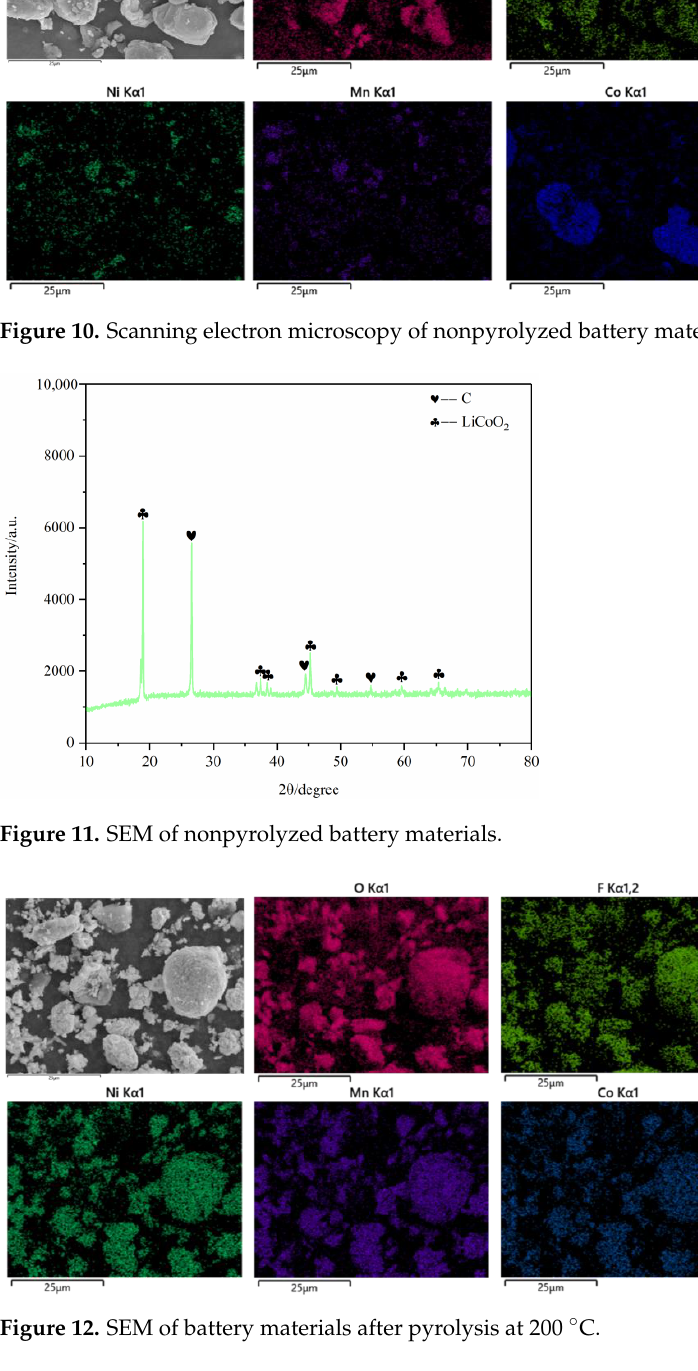
Figure 13. XRD of battery materials after pyrolysis at 200 °C. As shown in Figure 14, the battery materials were pyrolyzed at 400 °C in an N2 at- mosphere. After pyrolysis, the battery materials were broken and analyzed by scanning electron microscopy. At the same time, an XRD test was carried out on the battery material, and the results showed that the main phase in the battery material did not change, and the two main phases were still C and Li 2 CoO 2 , as shown in Figure 15.